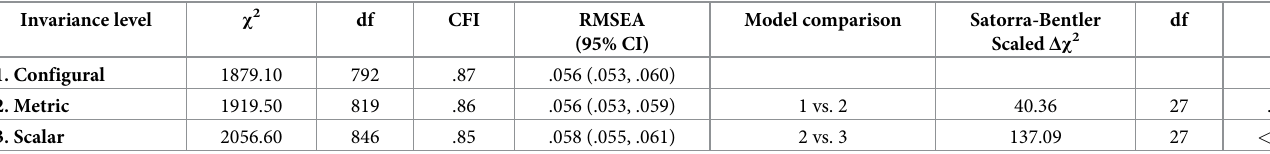
Table 2. Fit indices for gender invariance testing for the three factor model (cognitive, affective, somatic).